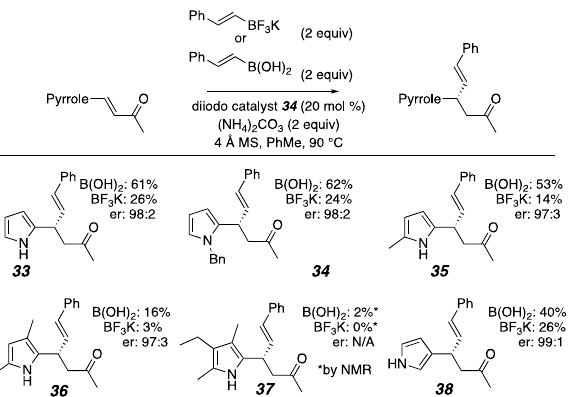
Figure 7. Pyrrole problems.